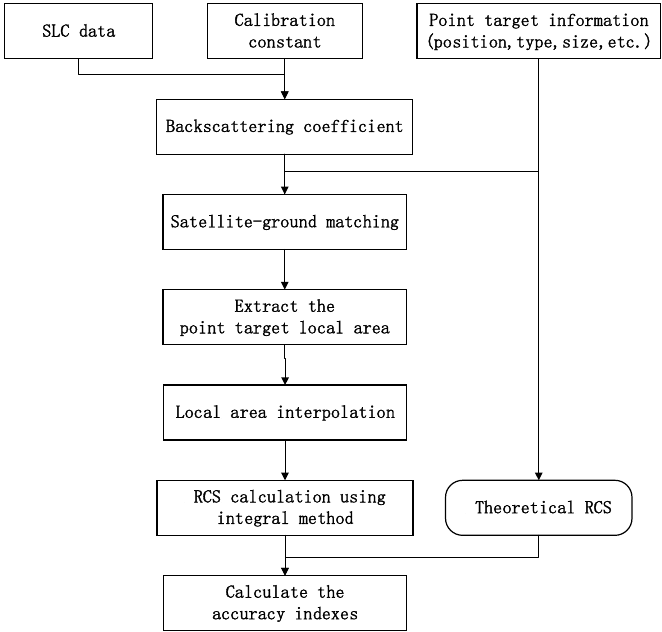
Figure 1. The validation process for the backscattering coefficient. k k × A symmetric imaging window of 2 2 size was selected, for which the point tar- get position was the center. Because the point target occupies fewer image elements in the